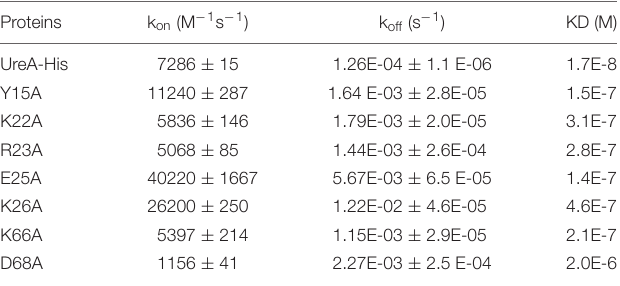
TABLE 2 | Values of k on , k off , and KD (k off /k on ) for Hsp60 binding to UreA-His and its mutants.